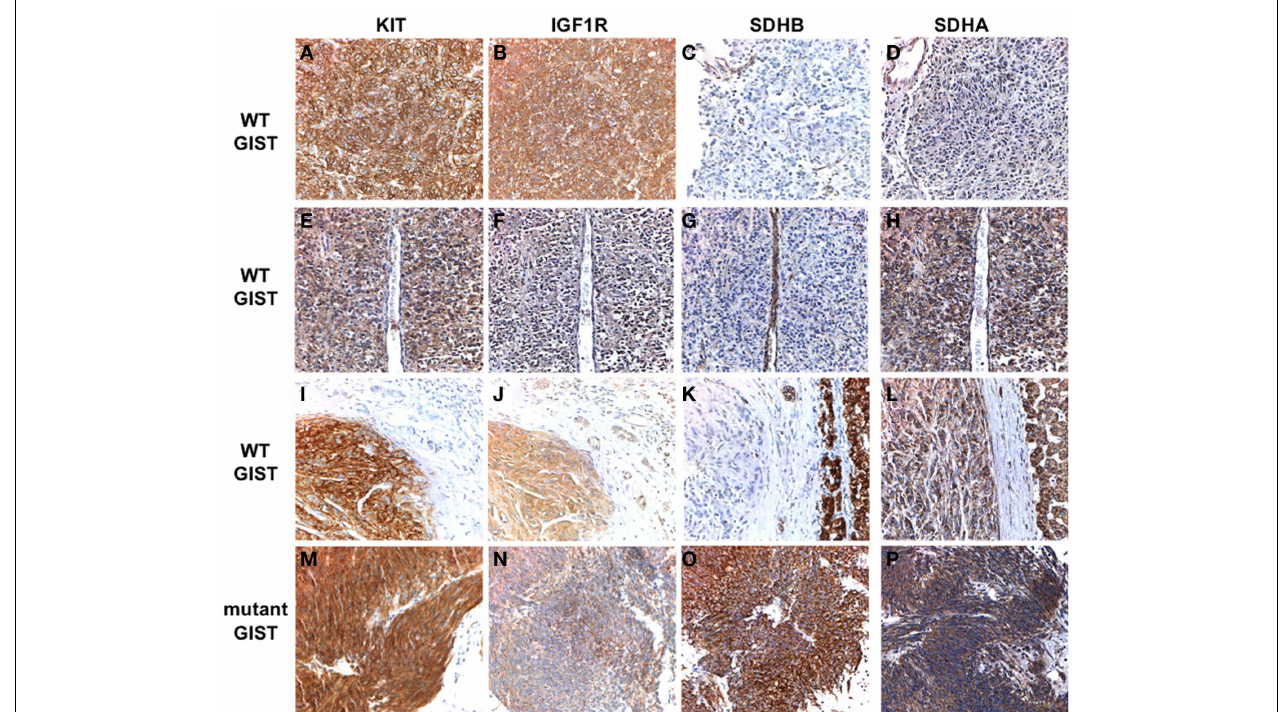
tumor tissue (C,G,K) . SDHA staining is absent in an SDHB-deficient GIST with a truncating SDHA mutation (D) . Positive SDHA staining is evident in an SDHB-deficient GIST harboring compound heterozygous missense SDHA mutations (H) , and in an SDHB-deficient GIST with no identified SDH mutations (L) as well as in the mutant GIST (P) . See text for more detailed mutation descriptions. GIST cases have been previously reported (Belinsky et al., 2012): (A–D) , case 2; (E–H) , case 1; (I–L) , case 10; (M–P) , case